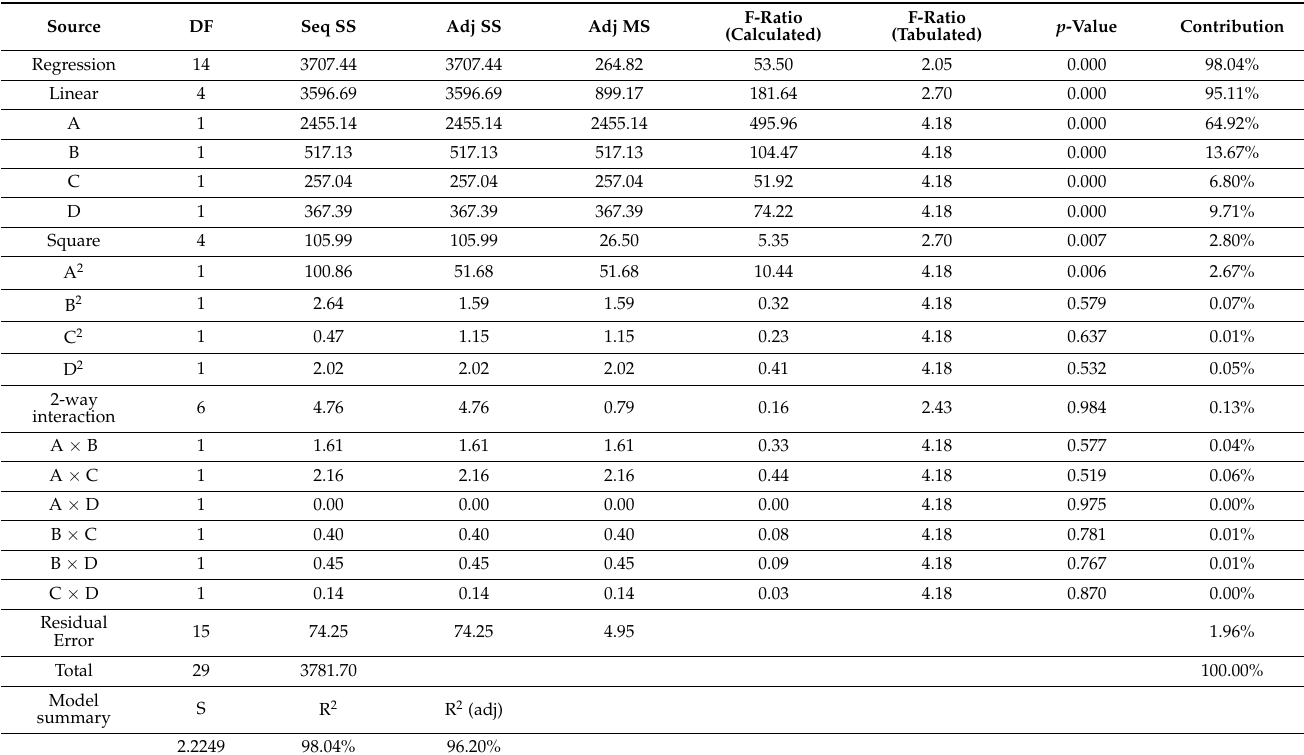
Table 15. ANOVA for drilling temperature of h-BN-loaded CEC.